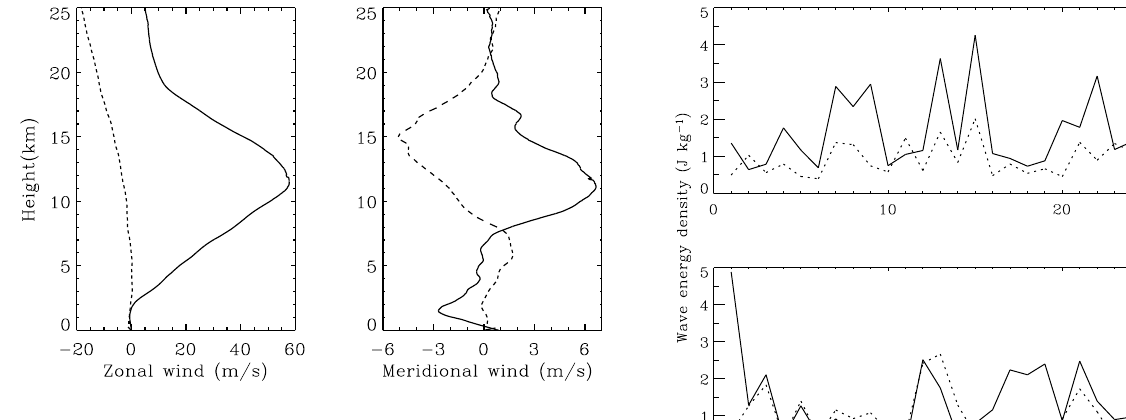
Fig. 2. Monthly averaged zonal (left panel) and meridional winds (right panel). The dotted and solid curves represent the observa- tion values in summer (August 2006) and winter (January 2007), respectively.